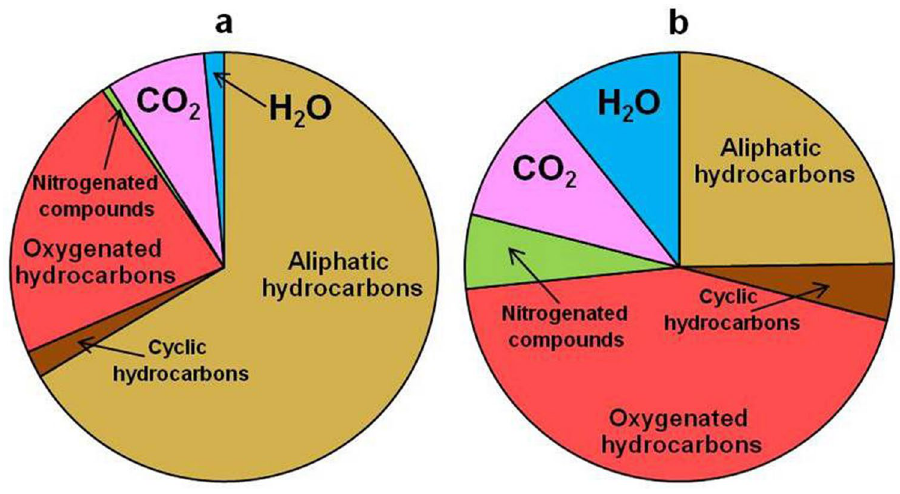
Figure 4. Relative contents of volatiles in synthetic diamonds grown in systems Fe–Ni–C ( a ) and Fe–Ni–Ti–C ( b